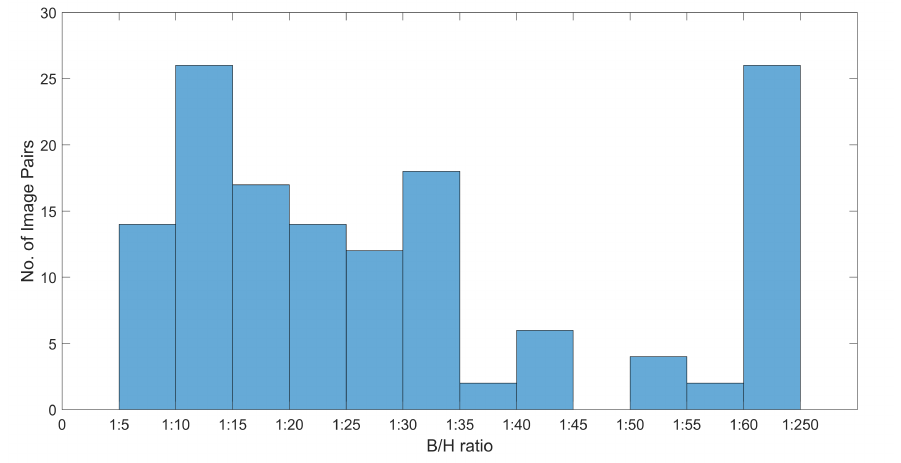
Figure 12. Histogram of B/H ratio of overlapping PlanetScope image pairs of Nanga Parbat test